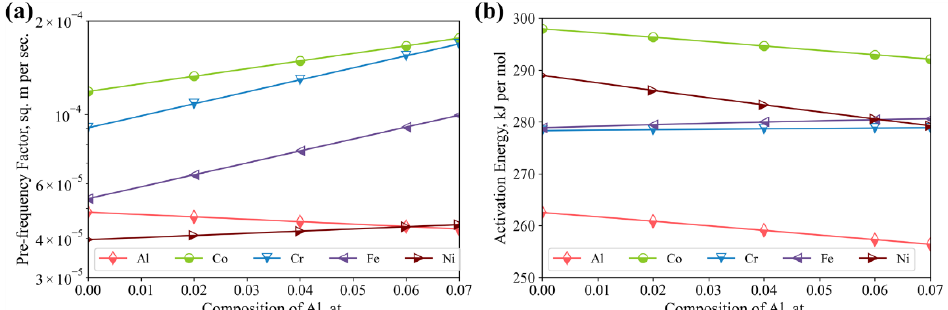
Figure 7. Influence of aluminum content on ( a ) pre-frequency factors and ( b ) activation energies of the tracer diffusion coefficients of the Alx(CoCrFeNi)1 − x alloys.